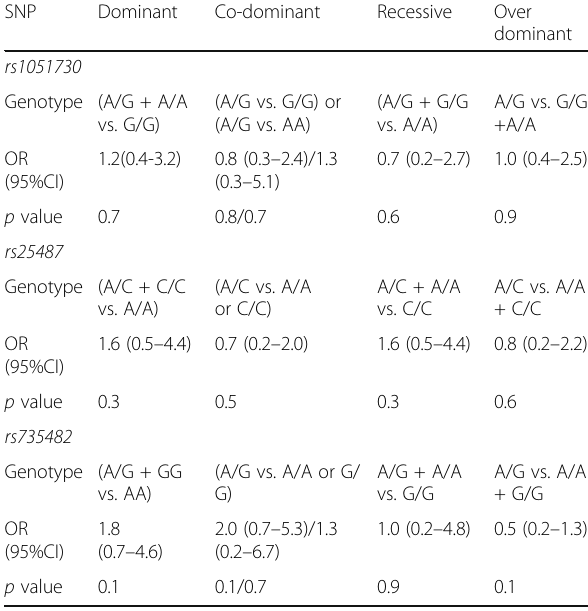
Table 3 Association of studied SNPs with lung cancer under different genetic models of